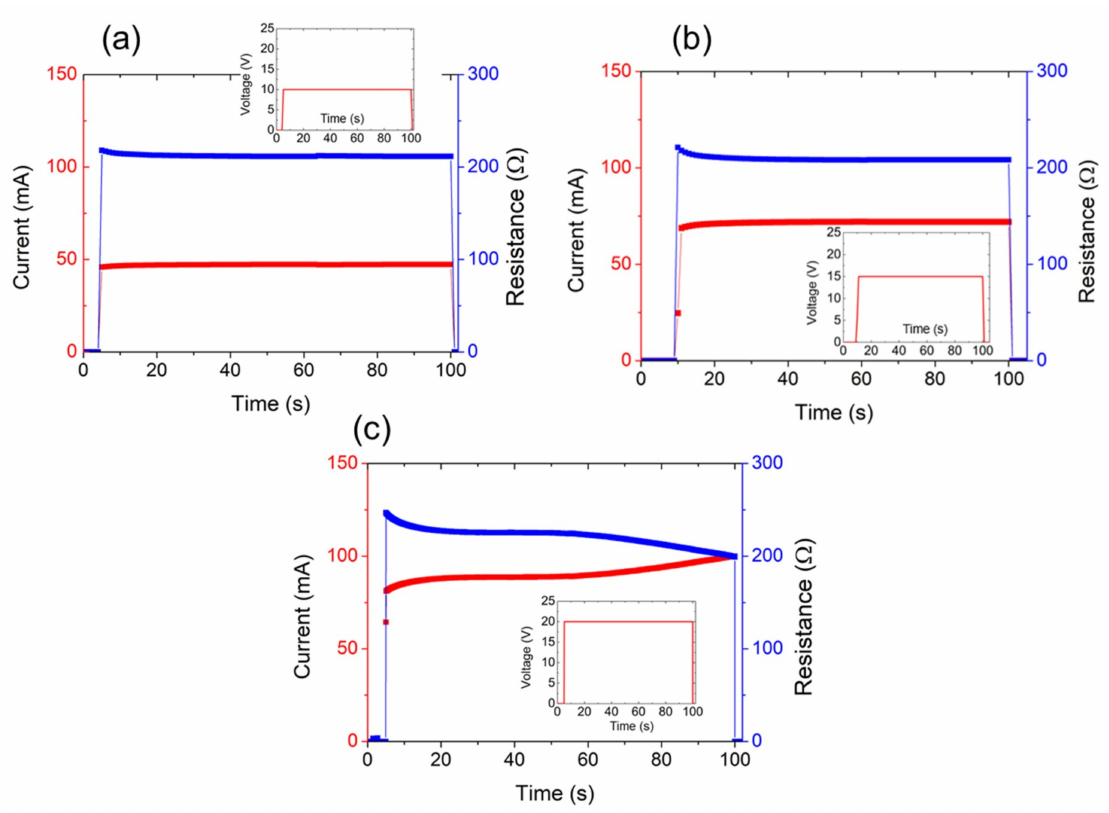
Figure 5. Resistance (blue) and current (red) over time of an LrGO-based heater for di ff erent step voltages of 10 V ( a ), 15 V ( b ), and 20 V ( c